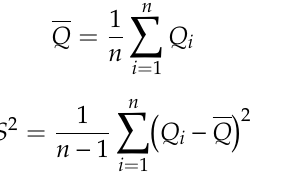
Figure 2. Convergence of annual and partial series—comparison of the method of ordinary moments and the graphical method (example on the Aisne River at Juzaine—station no. 2). With data samples, the standard estimators of the mean and variance are given by Equation (9) and